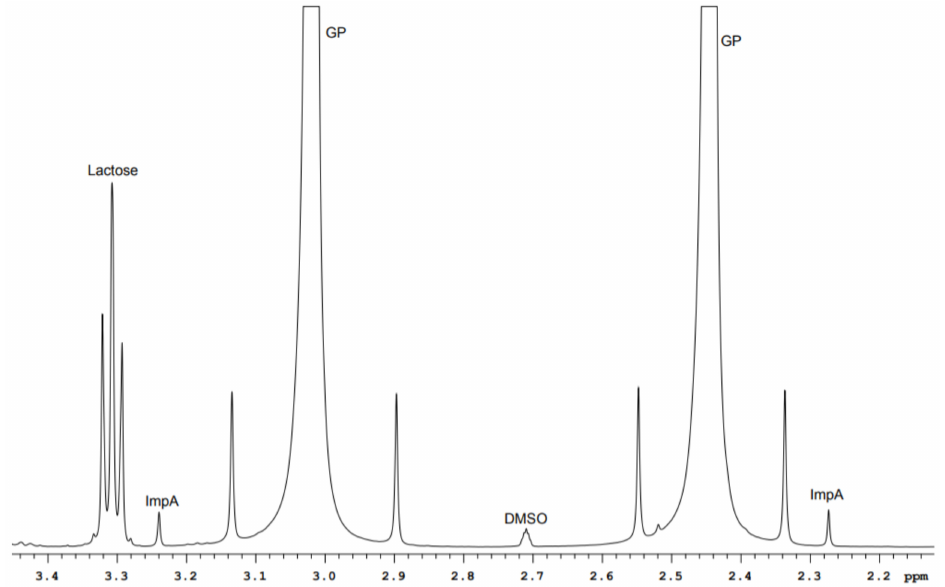
Figure 4. 1 H spectrum fragment of GP drug (capsules